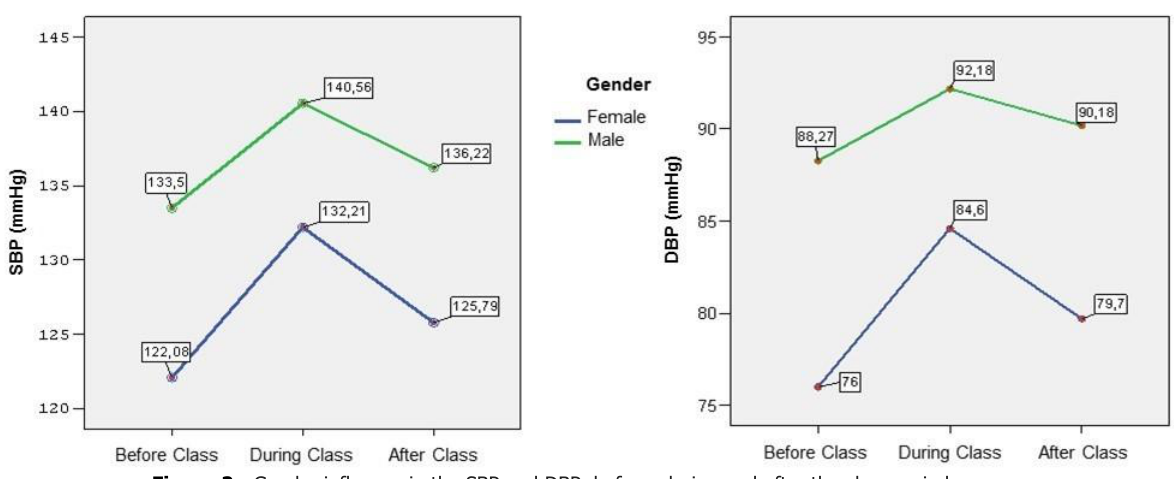
Figure 2 - Gender influence in the SBP and DBP, before, during and after the class